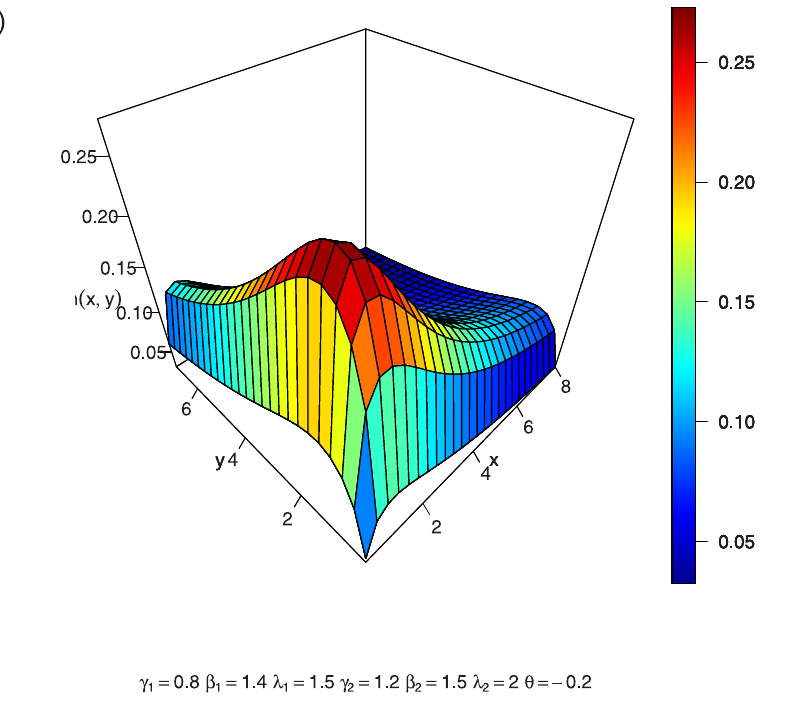
Fig 6. 3-dimension of joint hazard of